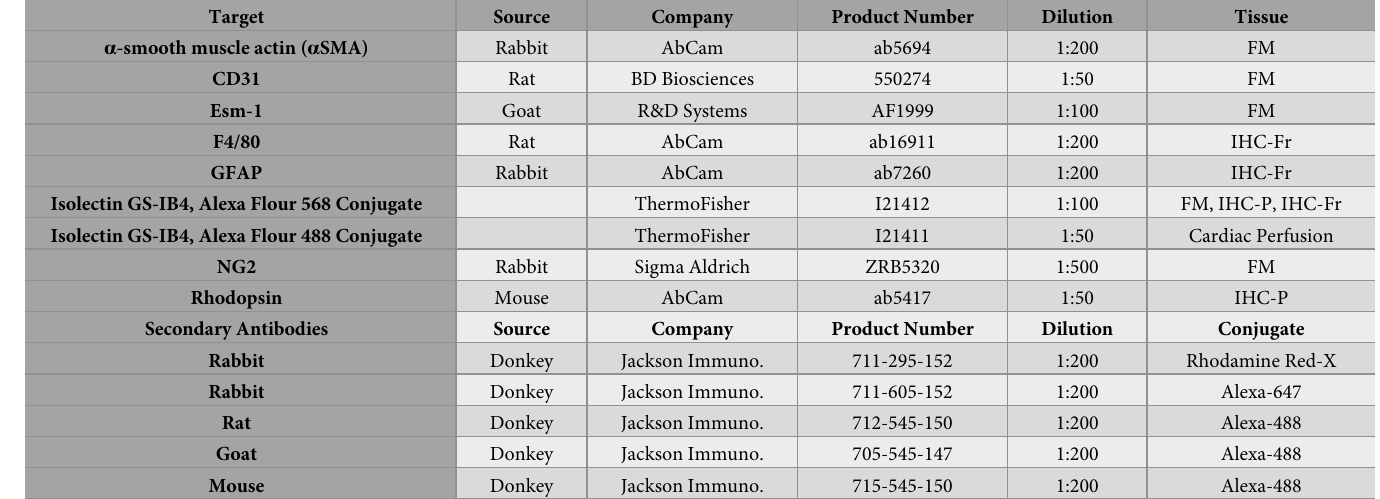
Table 1. List of antibodies and stains used for immunohistochemistry.